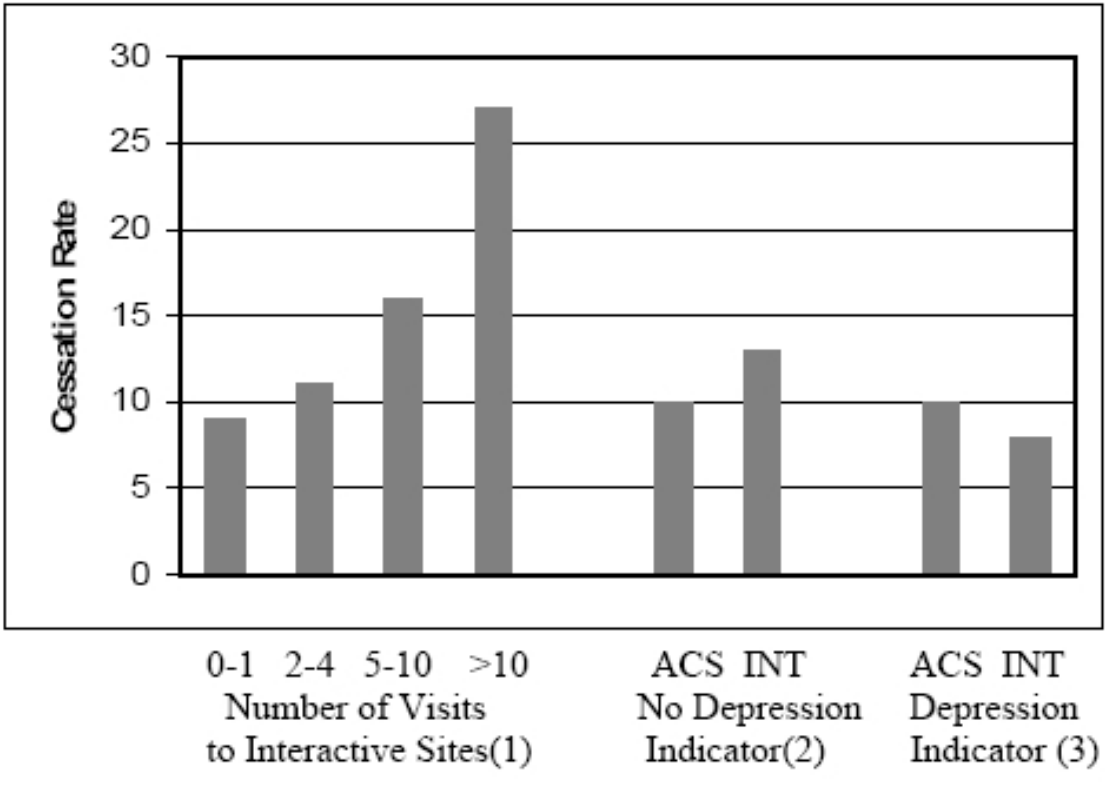
Figure 1. 13-month quit rates by number of visits, indicator of depression, and type of site, either interactive (INT) or static ACS site (cessation